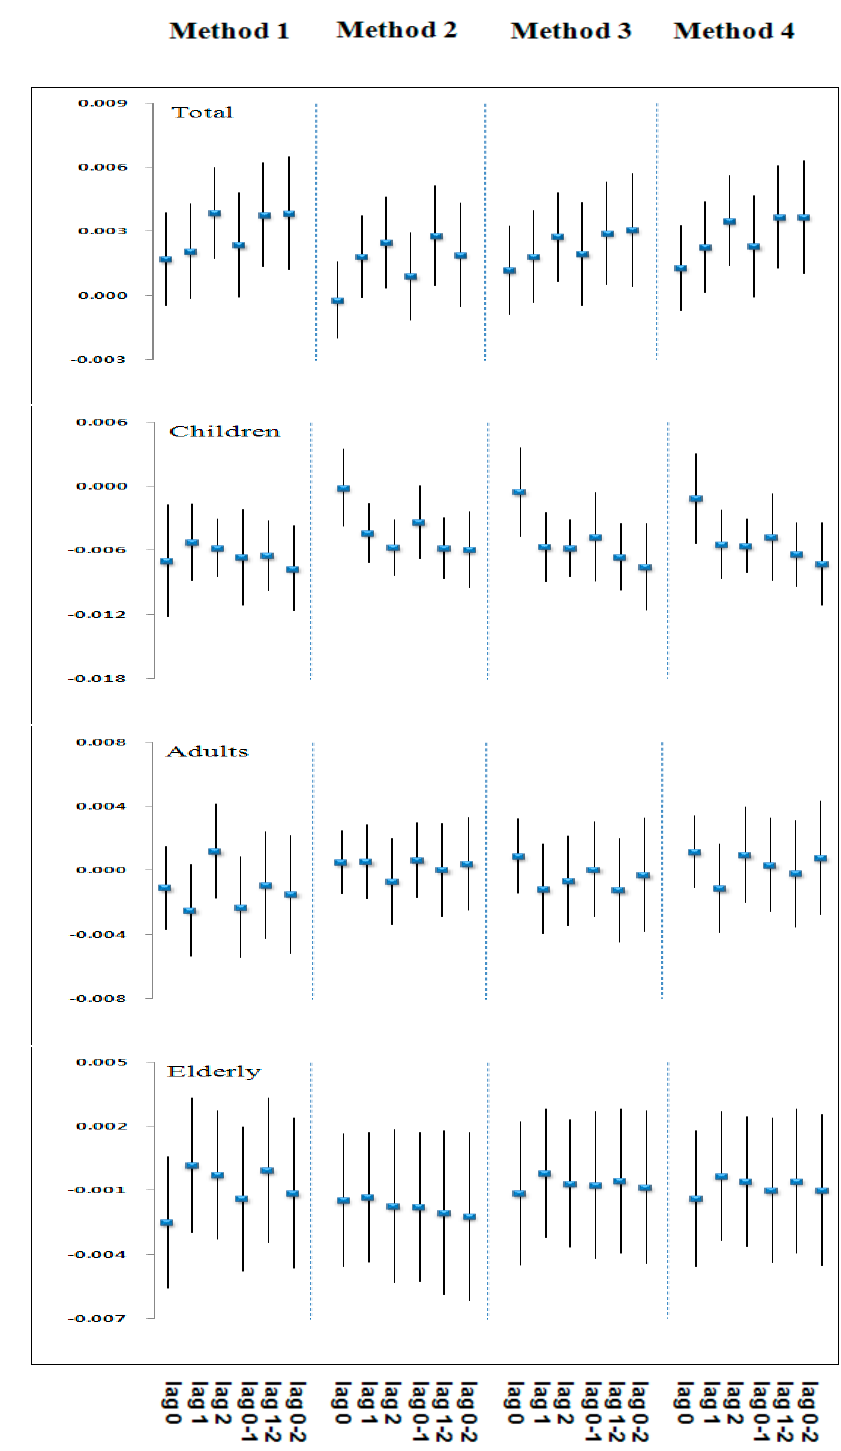
Figure 2. Change of FVC (L) by O 3 concentration for various lags and methods for estimating exposure.